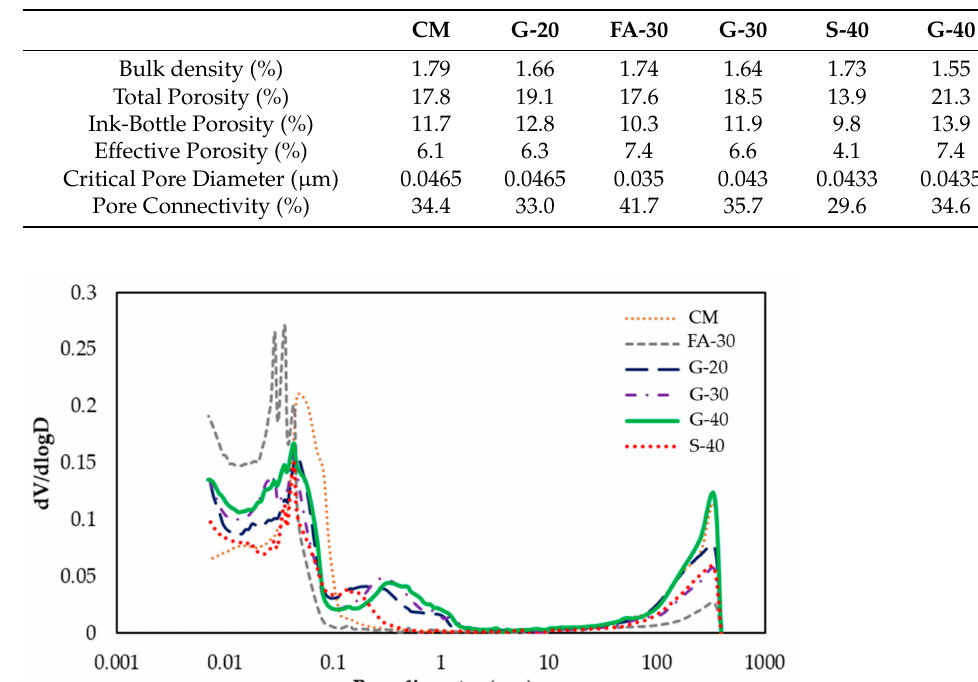
Table 8. Pore structure properties.